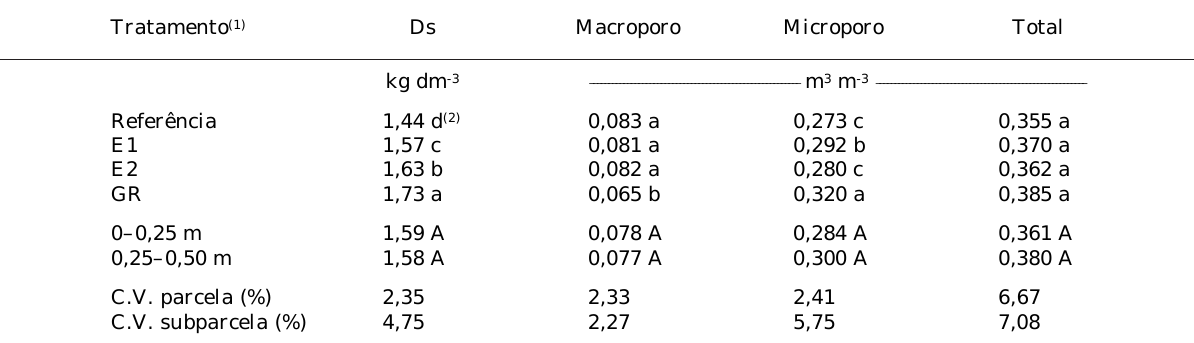
Quadro 1. Densidade do solo (Ds), macro e microporosidades e porosidade total em Latossolo